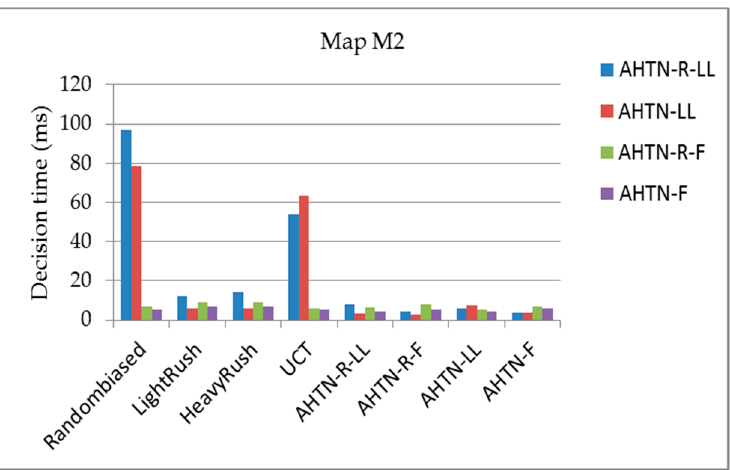
Figure 11. The average decision times of AHTN-R and AHTN with the two types of HTNs obtained over 100 games against each of the 8 algorithms, where the CPU time is 100 ms for map M2 (12 × 12 tiles). The playout time is 100 cycles.